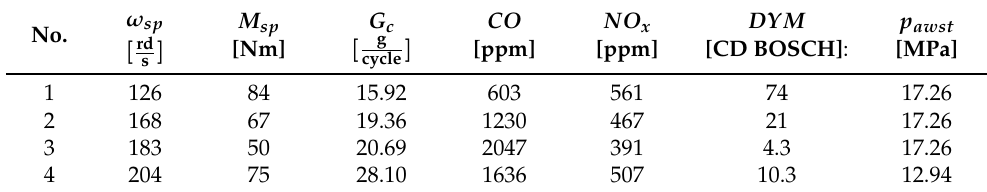
Table 11. Parameters of combustion engine duty points determined for accumulator with capacity V a = 0.05 [m 3 ] (load